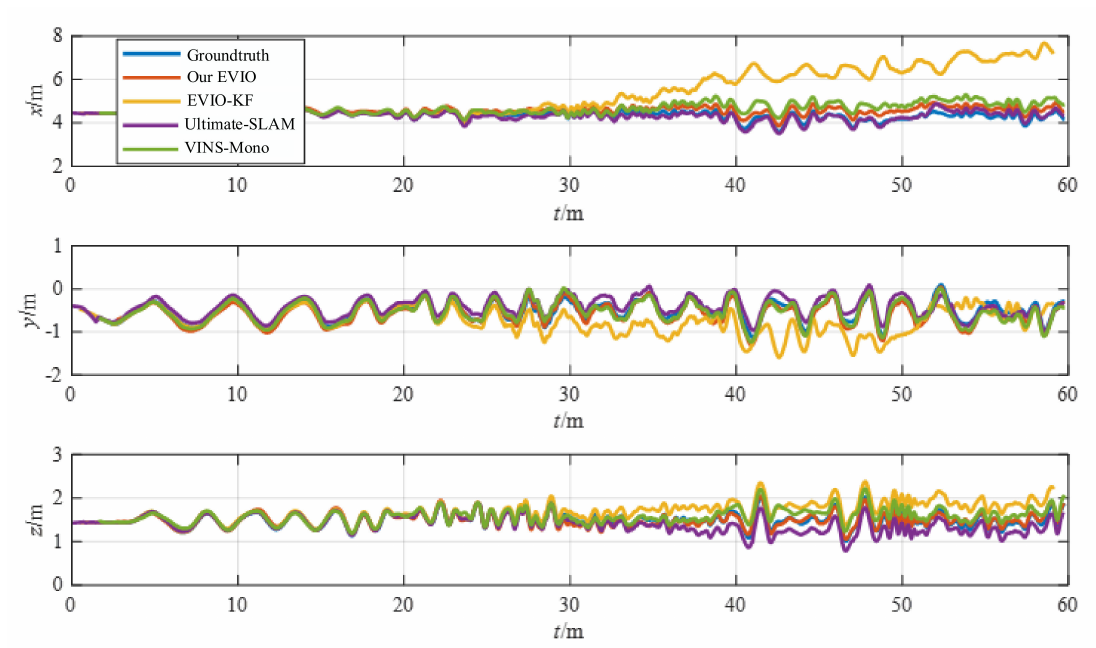
Figure 7. The position estimation of different algorithms for the poster_6dof.